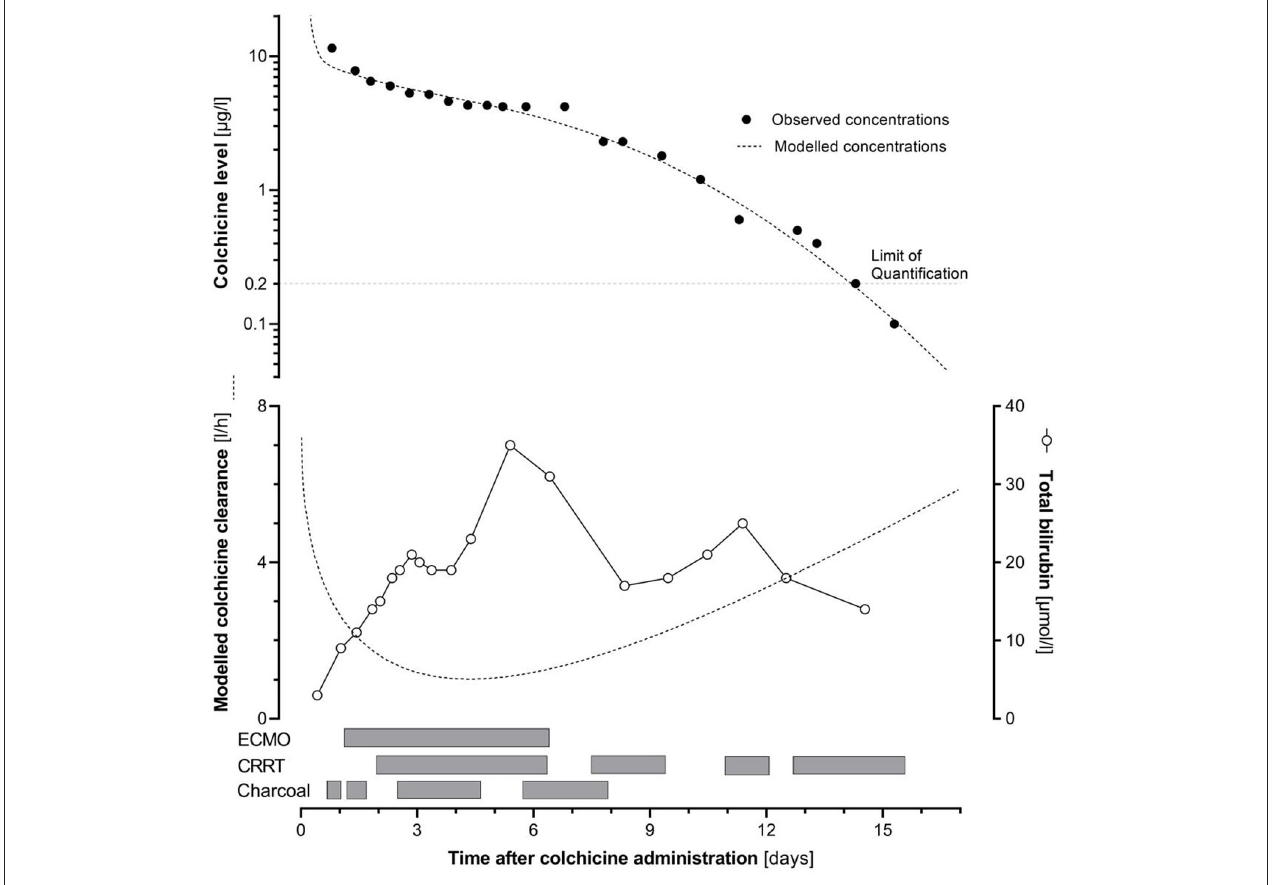
FIGURE 1 | Upper panel: time course of colchicine concentration (points: observed and line: modeled concentrations), in relation with the administration of activated charcoal, renal replacement therapy (CRRT), and extracorporeal membrane oxygenation (ECMO). Lower panel: time course of total bilirubin concentration (points) and of modeled colchicine clearance